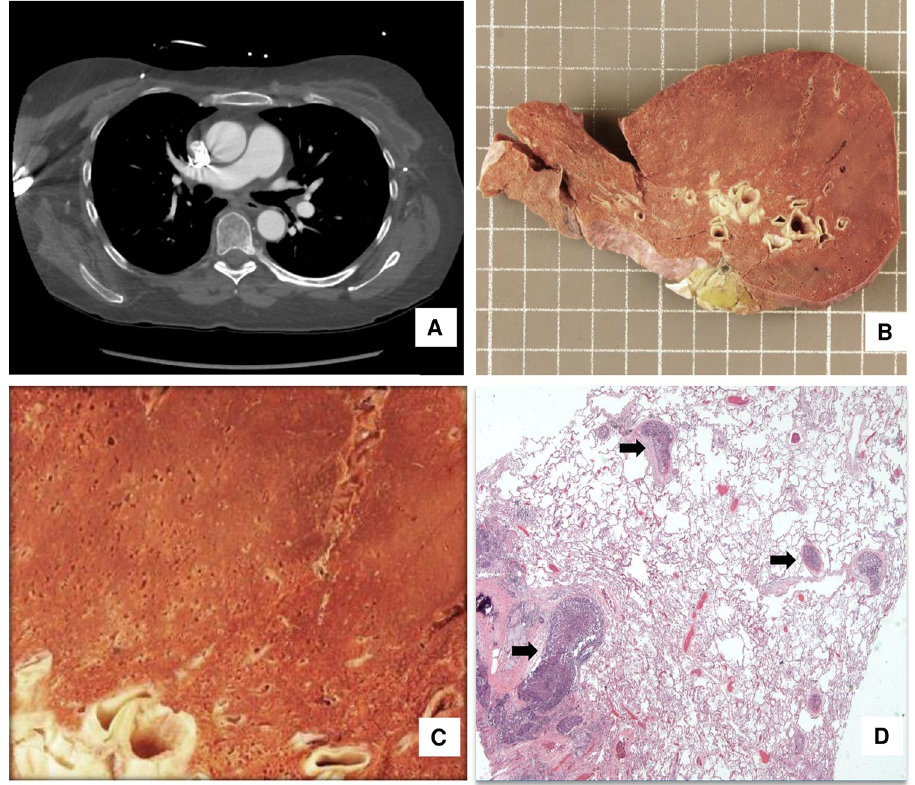
Fig 2. Representative case with microscopically but not grossly or radiologically detectable pulmonary tumor embolism in a patient with breast cancer. A. Radiographic image; B & C. Gross image of the lung; D. H&E image of the lung shows tumor emboli